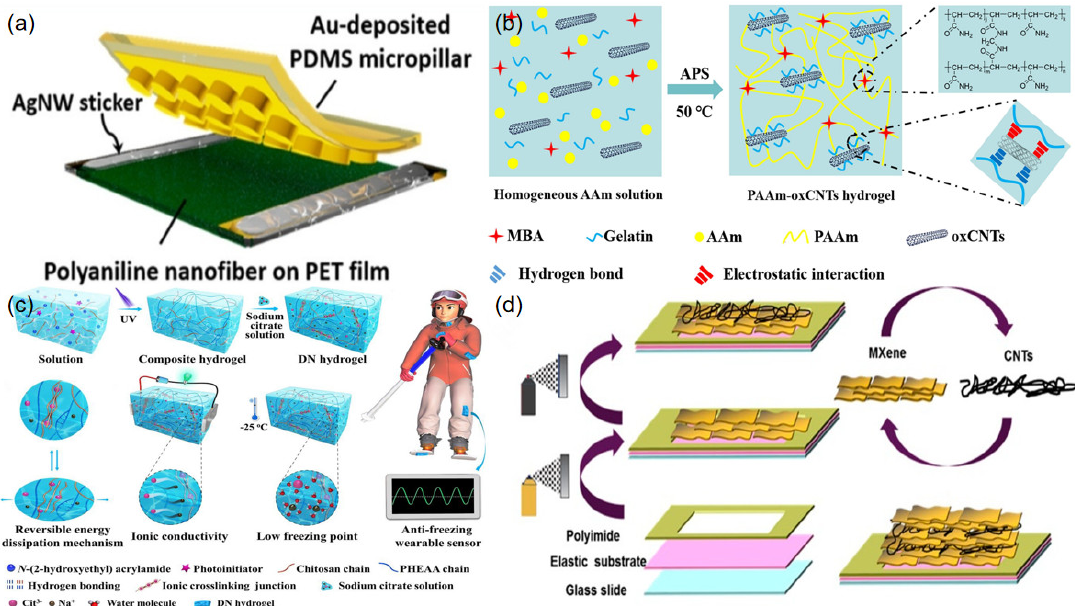
Figure 4. Schematic diagrams of flexible strain/pressure sensors using various materials: ( a ) polyaniline nanofibers and the conductive layer of Au (reproduced with permission from [85]); ( b ) carbon nanotube – reinforced hydrogel (reproduced with permission from [107]); ( c ) CS – PHEAA DN hydrogel (reproduced with permission from [108]); ( d ) Ti 3 C 2 Tx MXene/carbon nanotube composite (reproduced with permission from [110]).